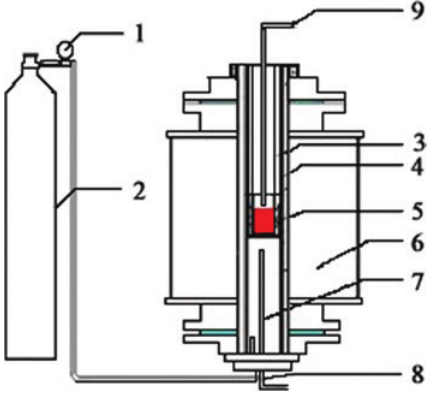
Fig. 1: Schematic diagram of the experimental apparatus. 1 – pressure gauge; 2 – argon; 3 – protective casing; 4 – carbon tube; 5 – melt; 6 – carbon tube furnace; 7 – temperature control system; 8 – input tube; 9 – temperature measuring